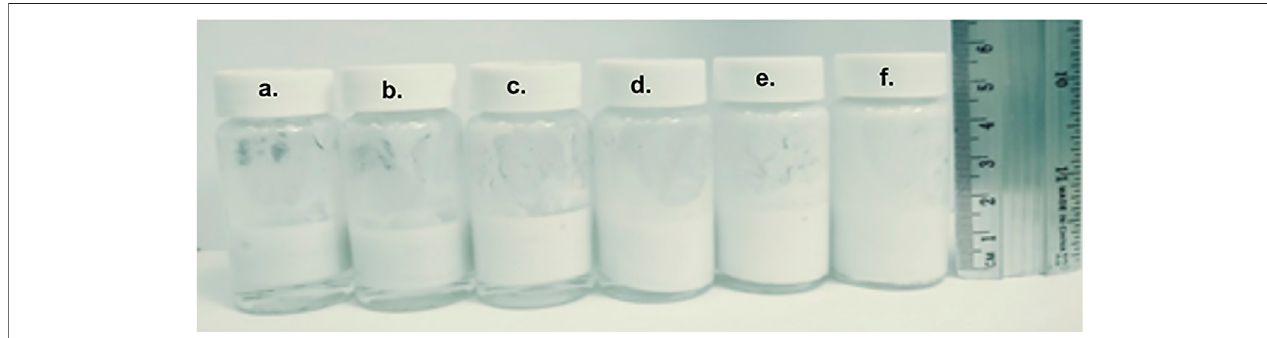
FIGURE 2 | Characterization of the titania-NH 2 Pickering emulsion oil/water ratio with NPs content of wt%: (A) 40:60, 0.4wt%. (B) 50:50, 0.4wt%. (C) 40:60, 1wt %. (D) 50:50, 1wt%. (E) 40:60, 2wt%. (F) 50:50, 2wt%.